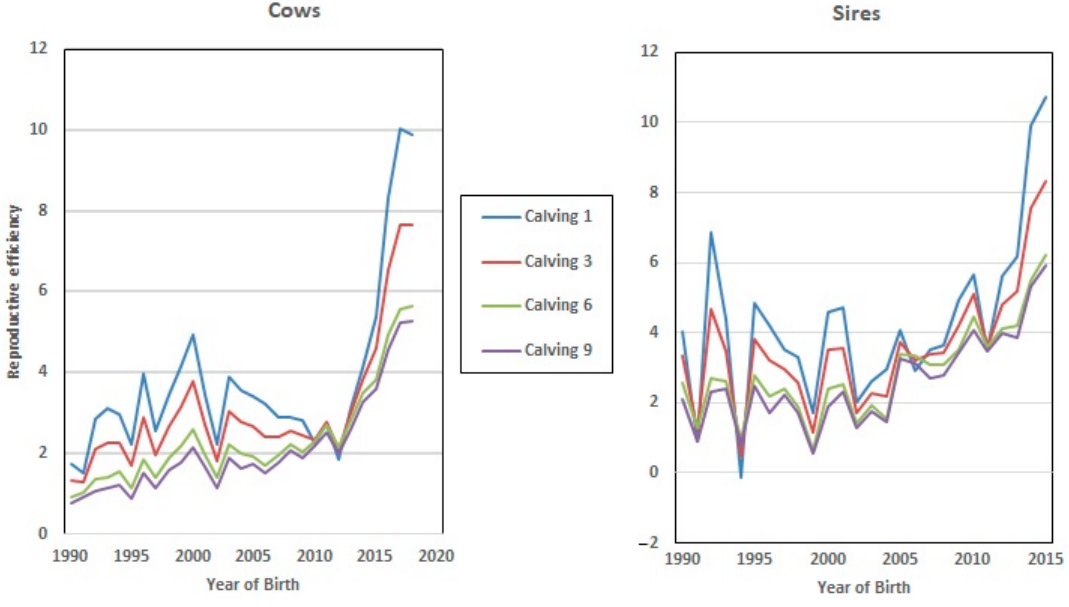
Figure 5. Genetic progress achieved in reproductive efficiency (Re) over a 30-year period.